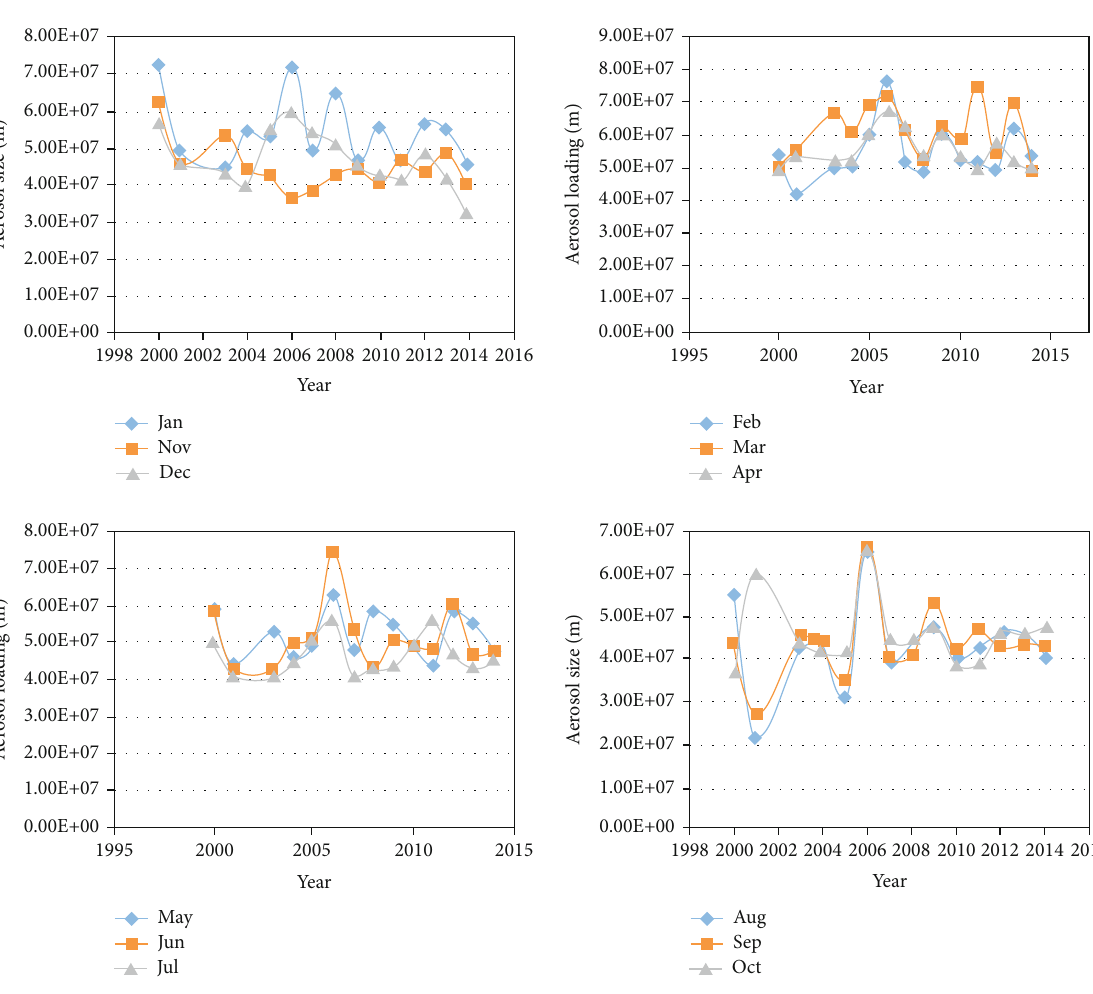
Figure 12: Aerosol size within four